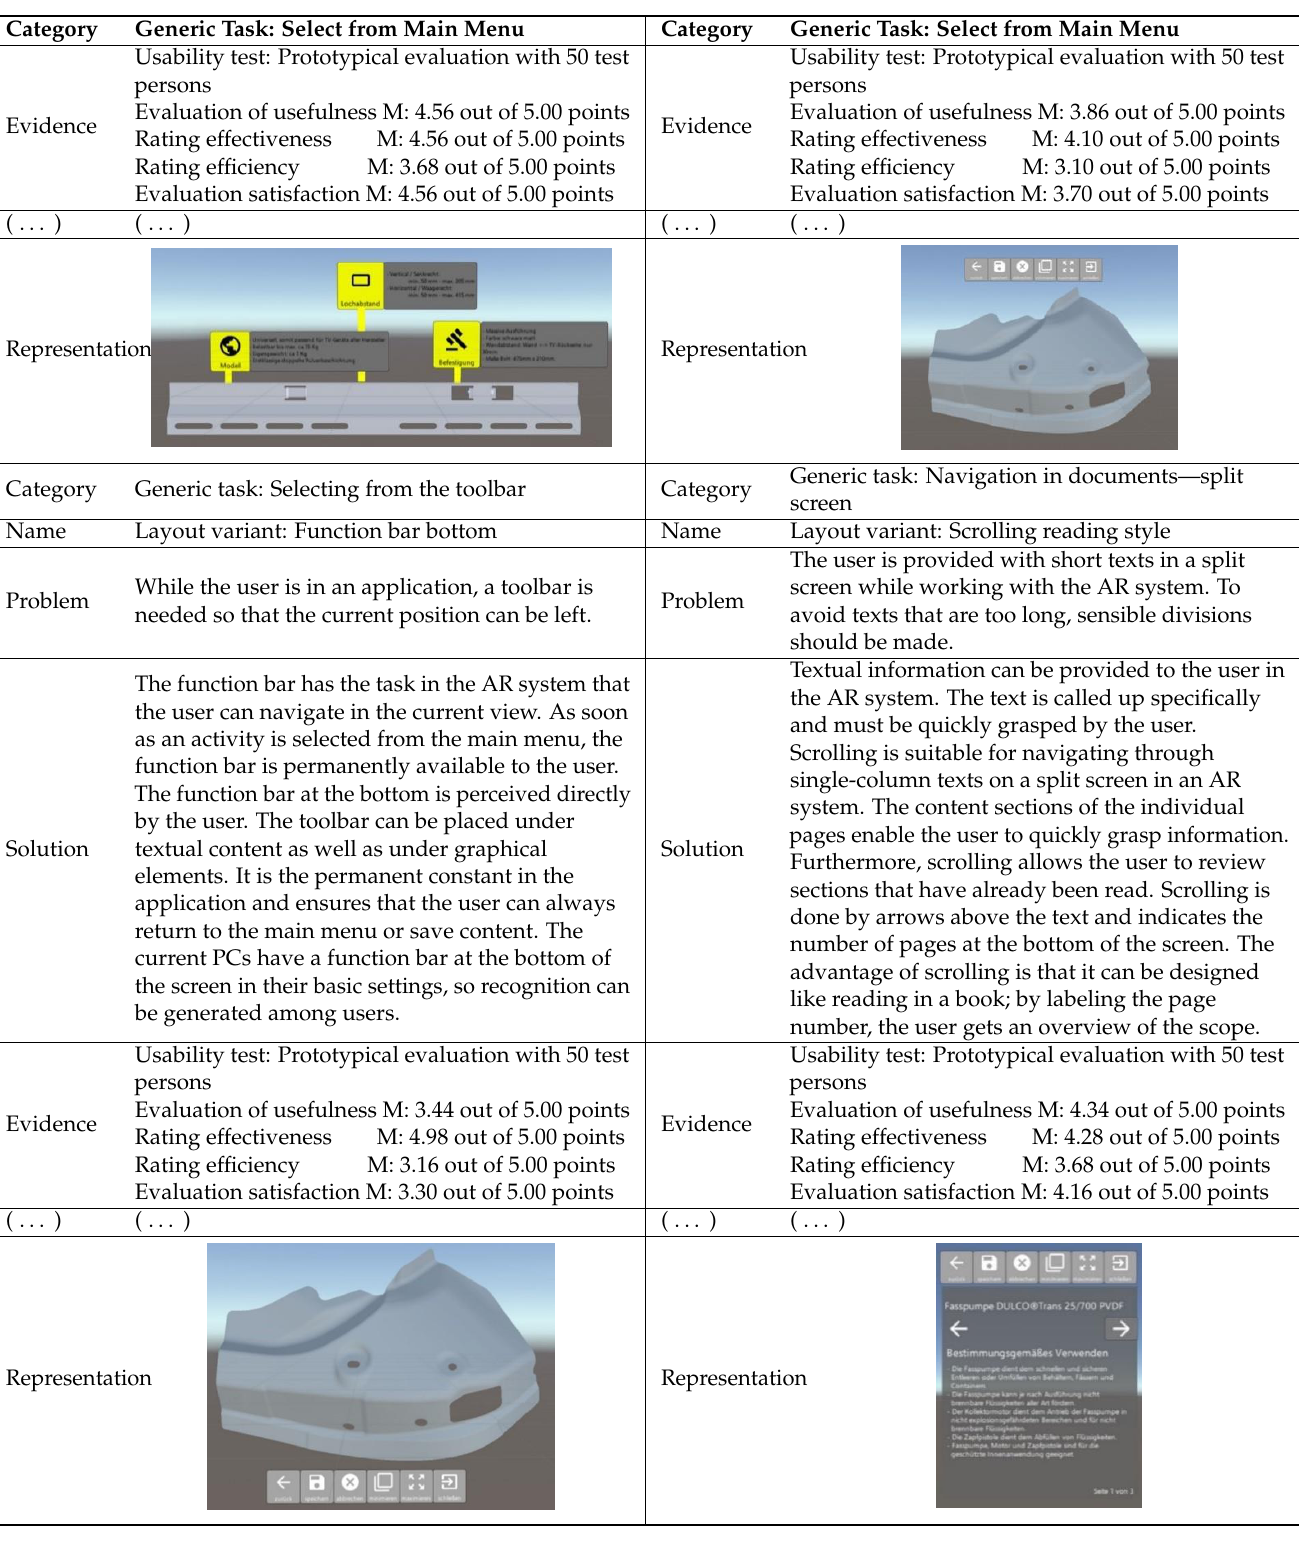
Table 13. Examples from the catalog with pattern. Part 2: Variants of interaction.